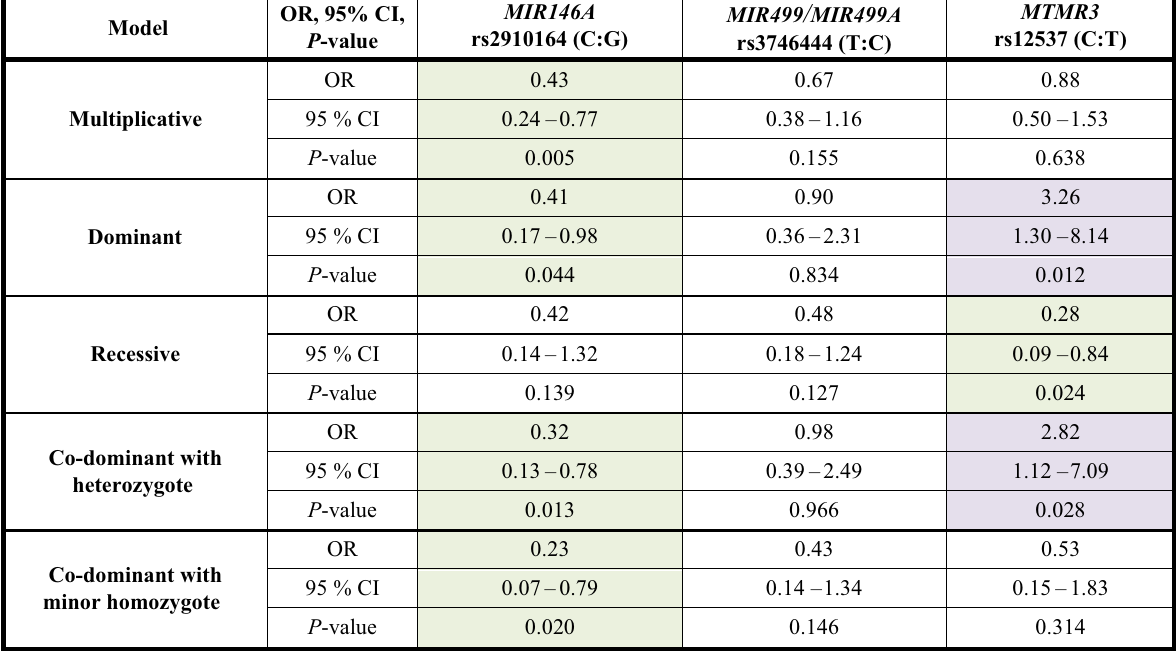
Table 2 Chosen RA SNPs